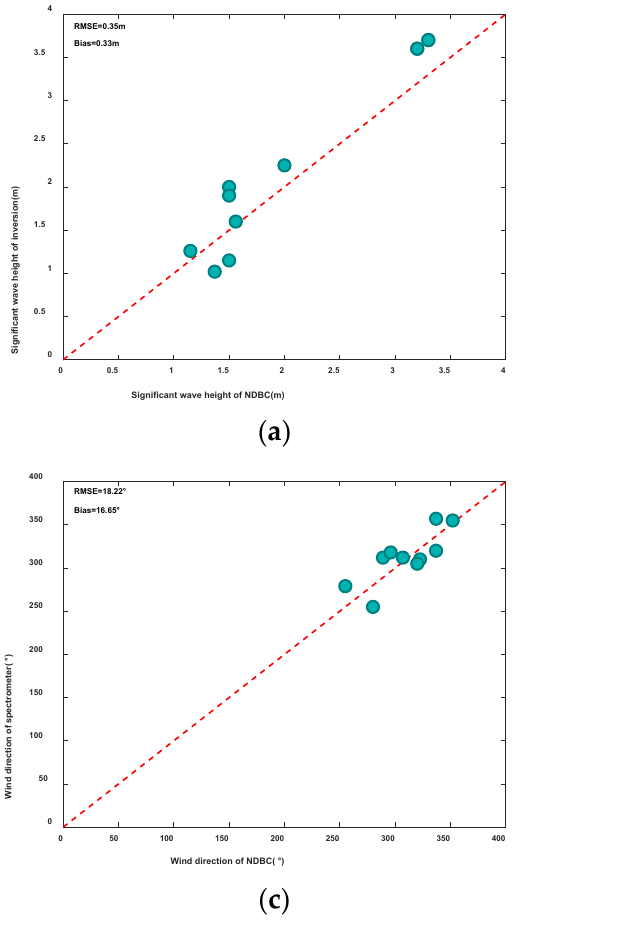
Figure 9. Comparison of the inversion results with buoy data: ( a ) Significant wave height; ( b ) Mean wave period; ( c ) Wind direction; ( d ) Wind speed.